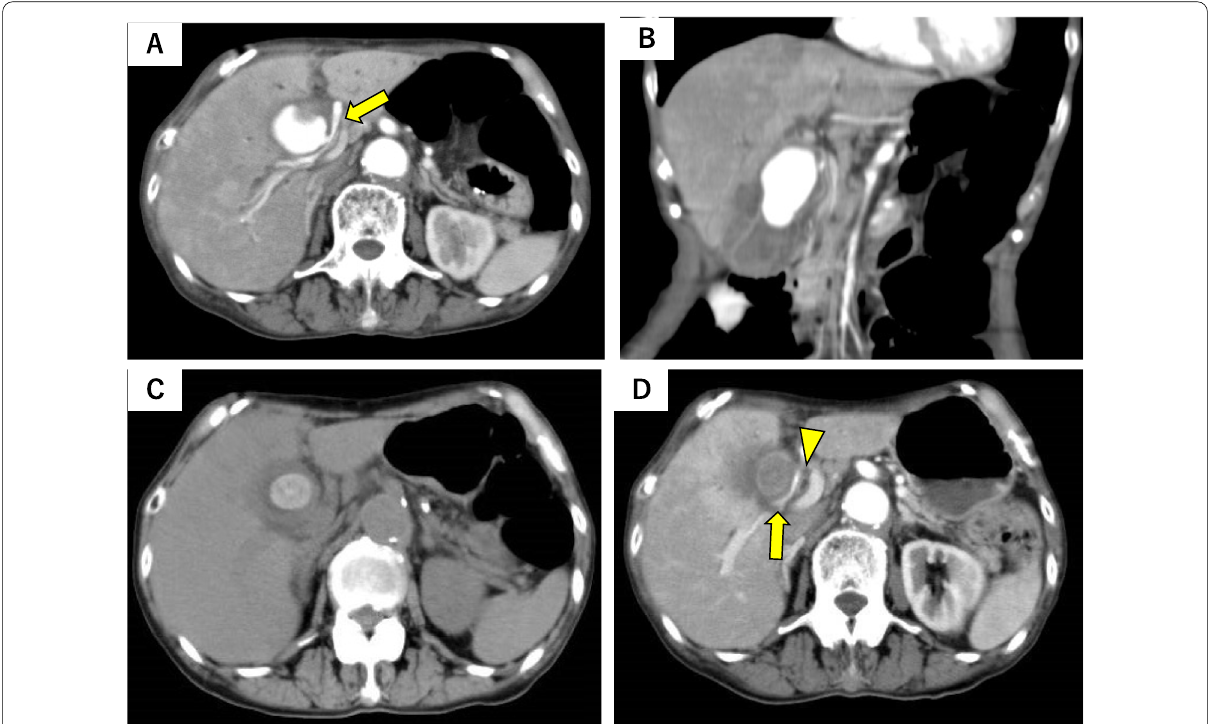
Fig. 1 Enhanced abdominal computed tomography (CT) findings. Enhanced CT revealed a pseudoaneurysm in the gallbladder, which was suspected to be connected to the right hepatic artery or the cystic artery A (yellow arrow) axial view, B coronal view. Moreover, CT revealed a 20-mm gallstone in the neck of the gallbladder ( C ). The right hepatic artery (yellow arrow) runs ventral to the common bile duct (yellow arrowhead) and is in close proximity to the gallbladder ( D